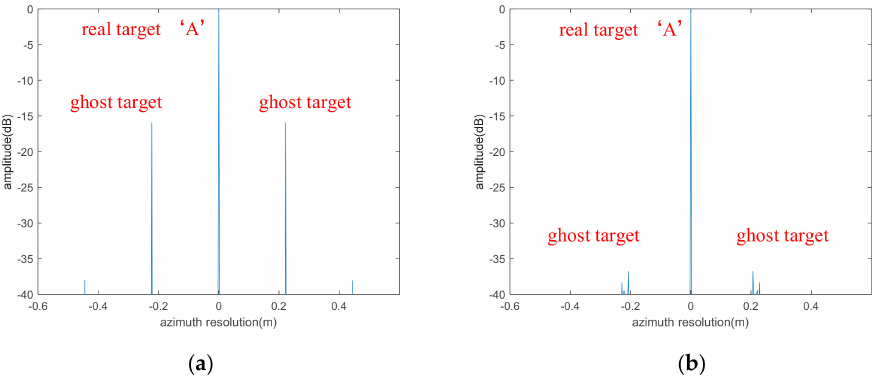
Figure 25. The imaging result after compensating vibration component 1 ( a ) and compensating vibration component 2 ( b ) using SoI 2